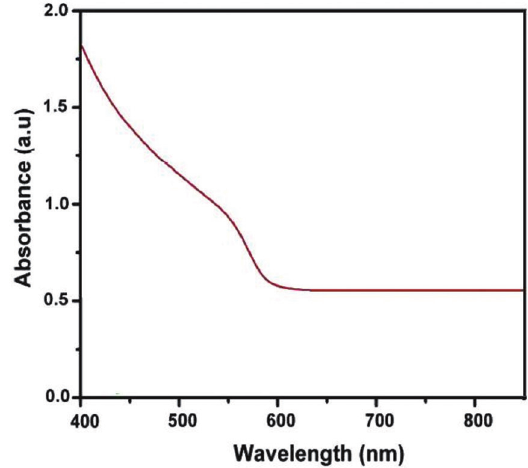
Figure 3: Optical absorption spectrum of CoS thin film